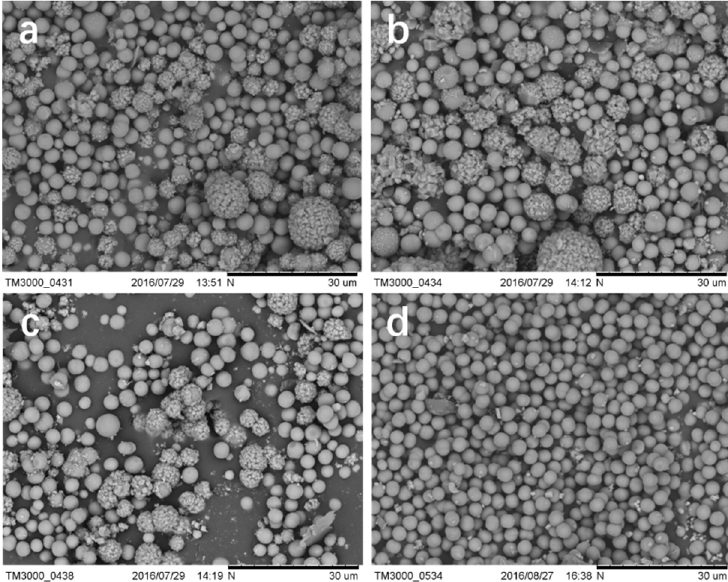
Figure 4. SEM images of the products after hydrothermal treatments with different time ( t h ). ( a ) 3 h; ( b ) 6 h; ( c ) 9 h; and ( d ) 24 h. R M = 1:1:1 (Ni:Co:Mn); C M = 0.15 mol · L − 1 ; C (NH4)2CO3 = 0.15 mol · L − 1 ; and T h = 180 °C.